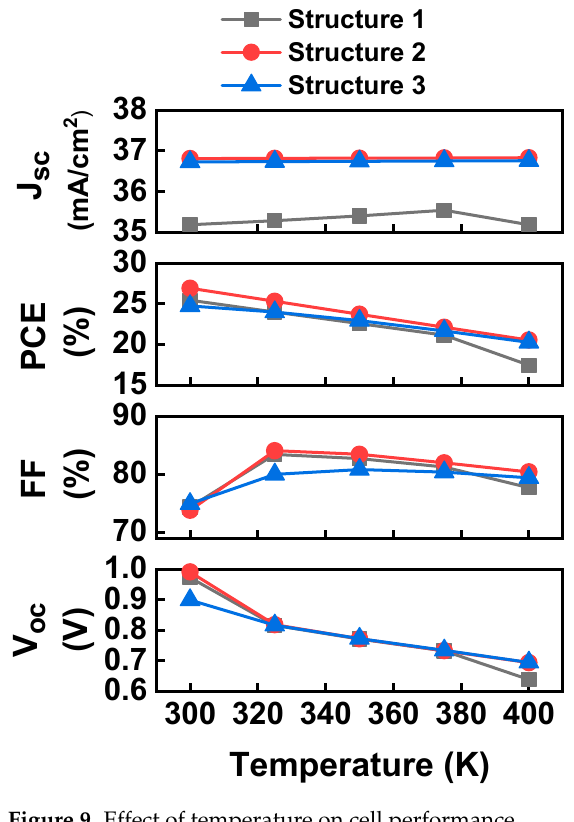
Figure 9. Effect of temperature on cell performance.